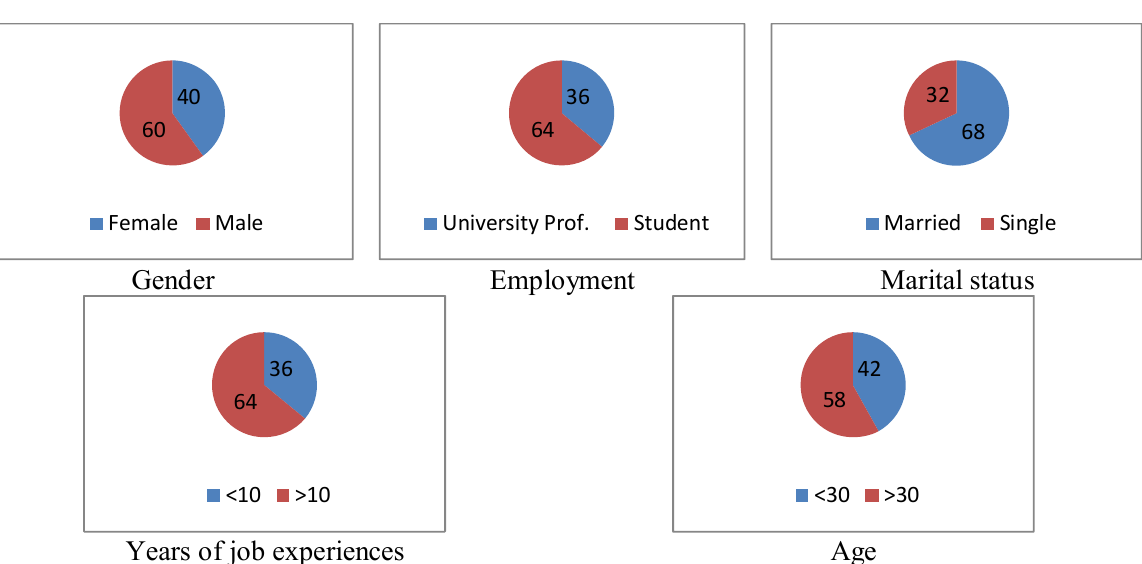
Fig. 1. Personal characteristics of the